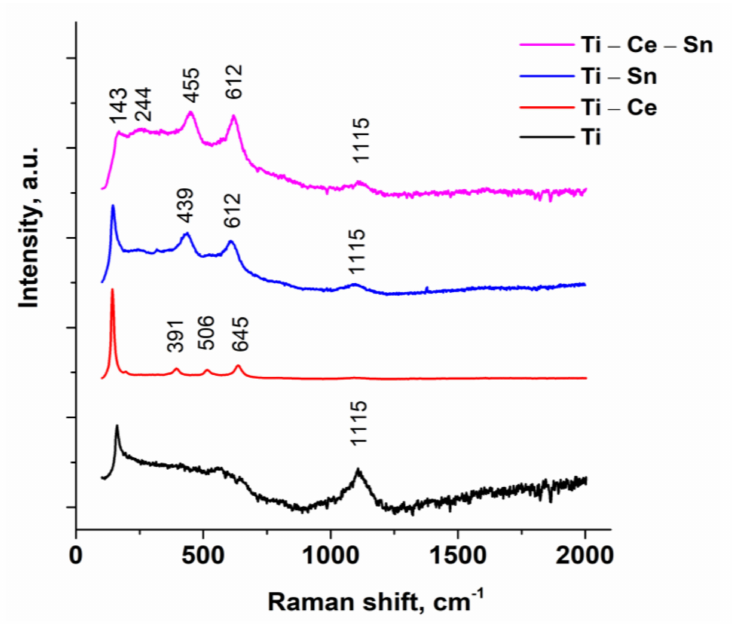
Figure 4. Raman spectra of prepared